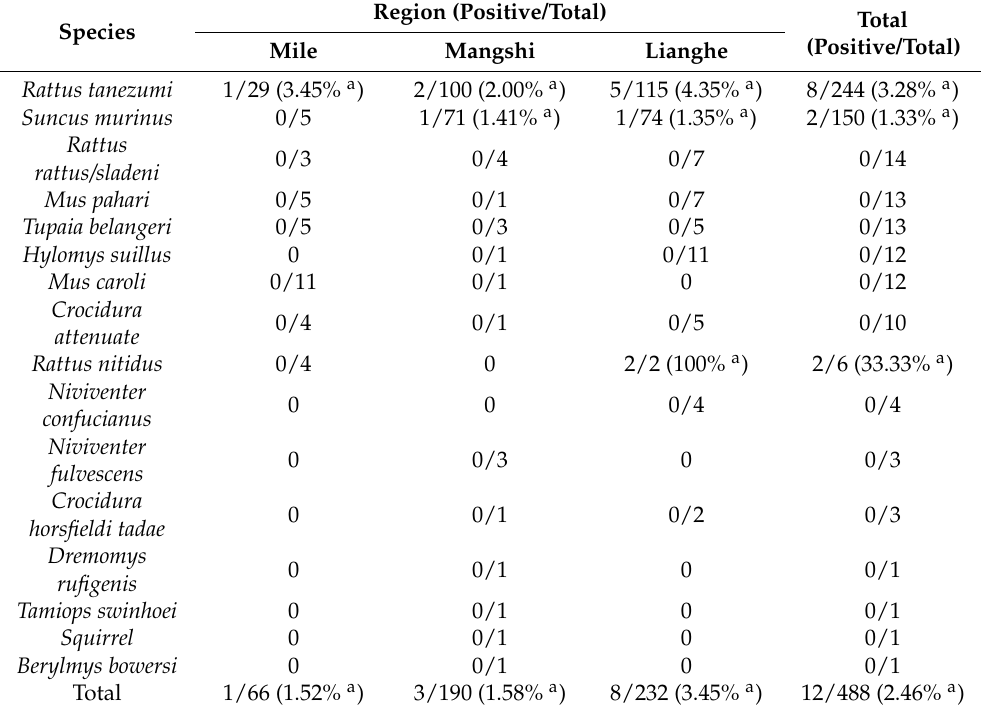
Table 1. Detection of HV in murine-shaped animals in Yunnan Province,